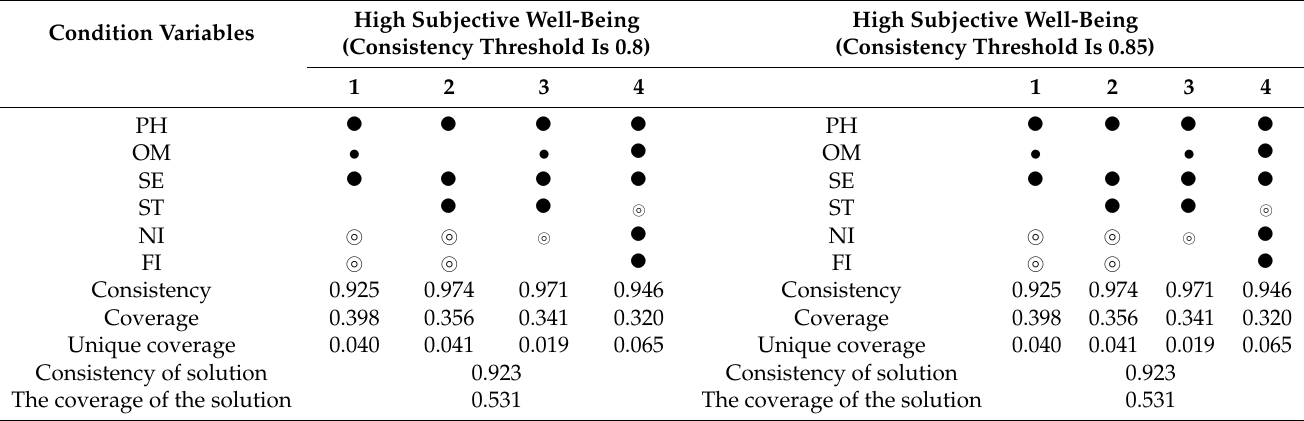
Table A2. Robustness test for increasing case consistency threshold.